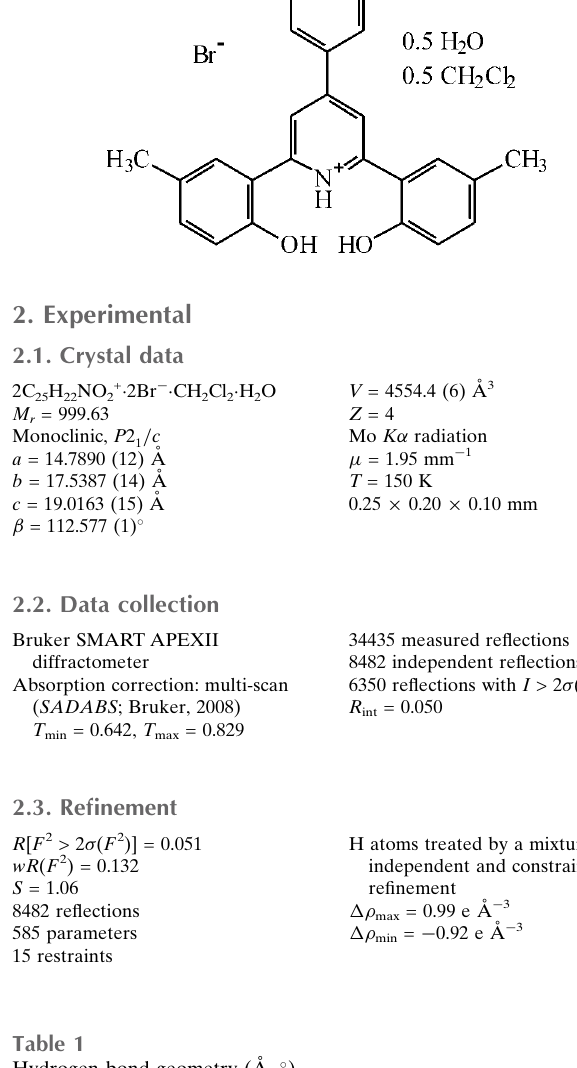
Hydrogen-bond geometry (A˚ , (cid:4)